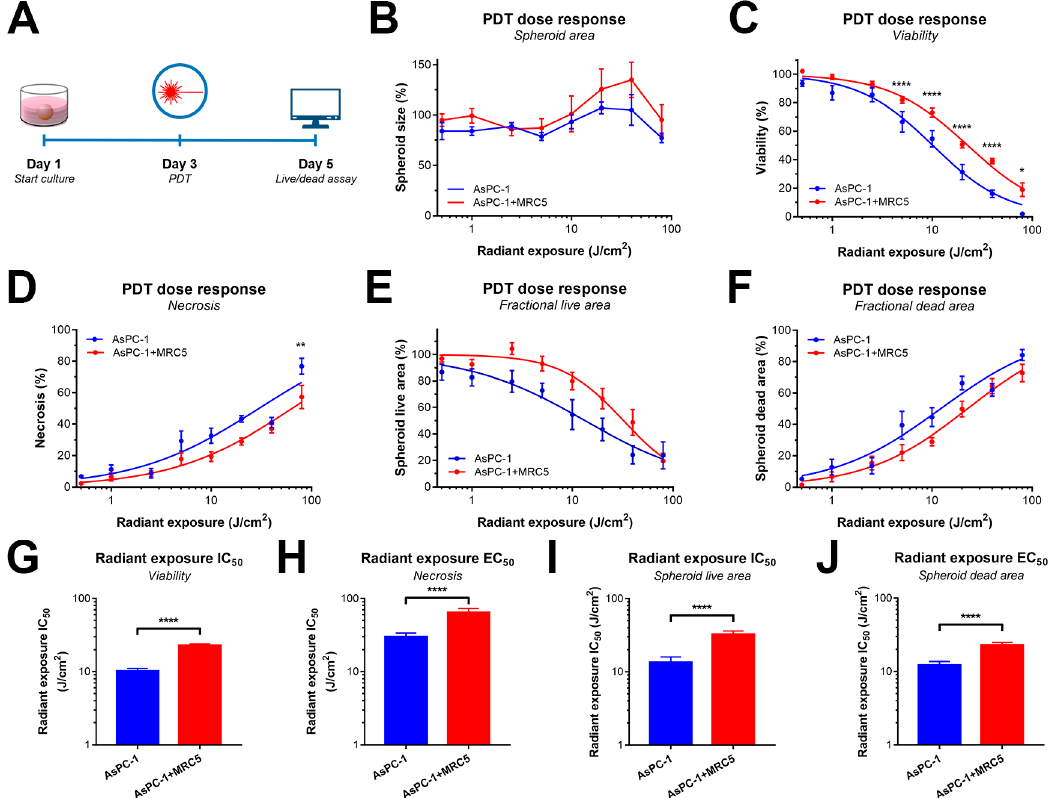
Figure 3. PDT efficacy was reduced by the presence of MRC5 fibroblasts in AsPC-1 spheroids. ( A ) Experimental timeline. ( B – F ) PDT dose-response in AsPC-1 (blue) and AsPC-1 + MRC5 spheroids (red) based on spheroid viability (B), necrosis (C), spheroid size (D), fractional live area (E), and fractional dead area (F). Data depict the mean ± SEM of N = 12 obtained from three technical repeats. ( G – J ) IC 50 and EC 50 values were extracted from the dose-response curve fits. Statistical significance is indicated as * p < 0.05, ** p < 0.01, *** p < 0.005, or **** p < 0.001.